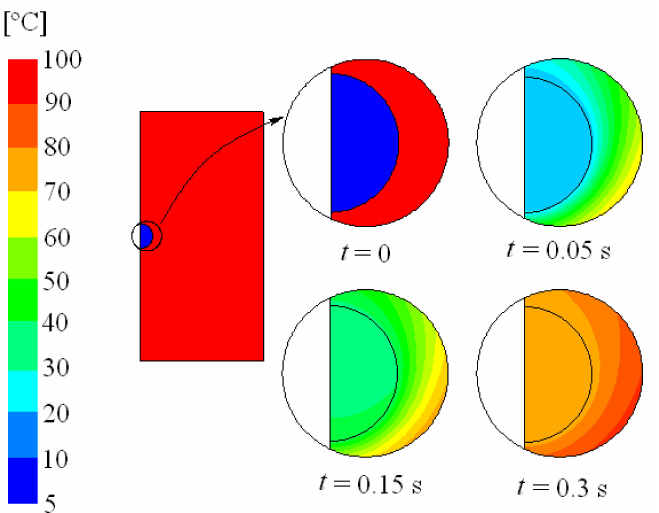
Figure 12. Temperature field for time (t) 0, 0.05, 0.15, and 0.3 s; 5% initial ammonia concentration,